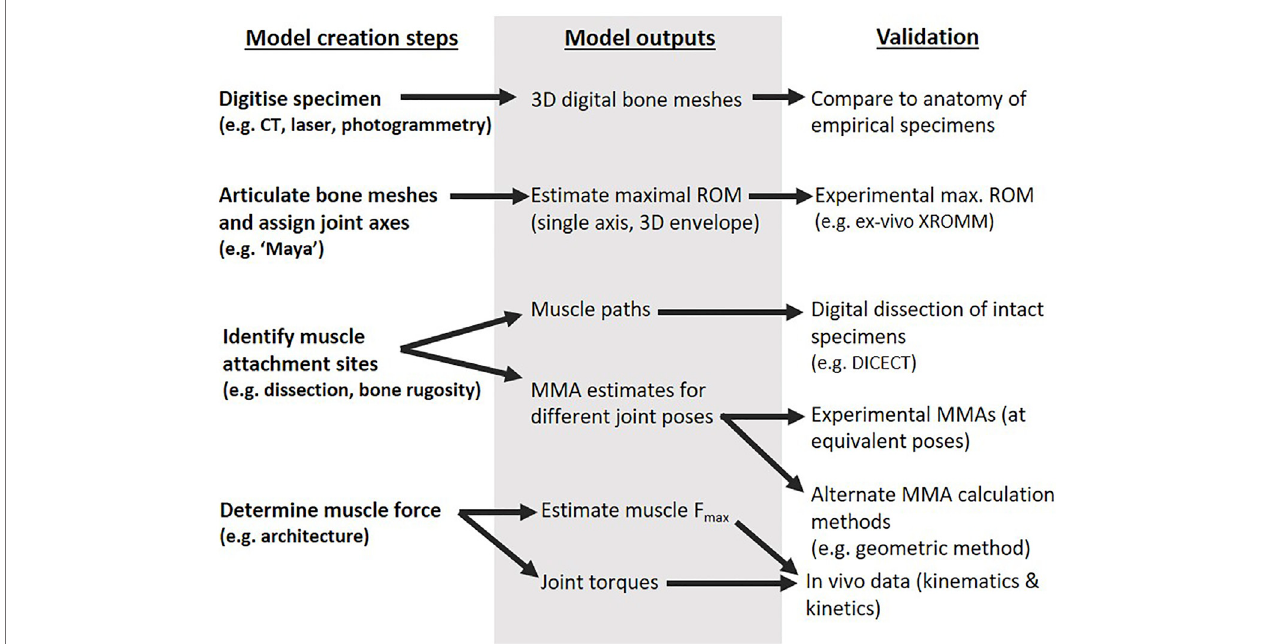
FIGURE 1 | Different components of the musculoskeletal modelling process as detailed in the